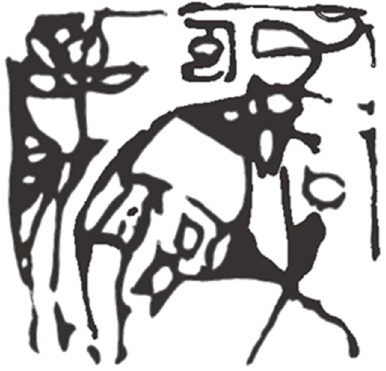
Figure 3. A Song Yuan Huaya with a deer motif and a Phagspa character “Ji”. The Yuan Dynasty. Inventory number: 0668. Sketched by author. Picture source: Wen (1995), p. 194.